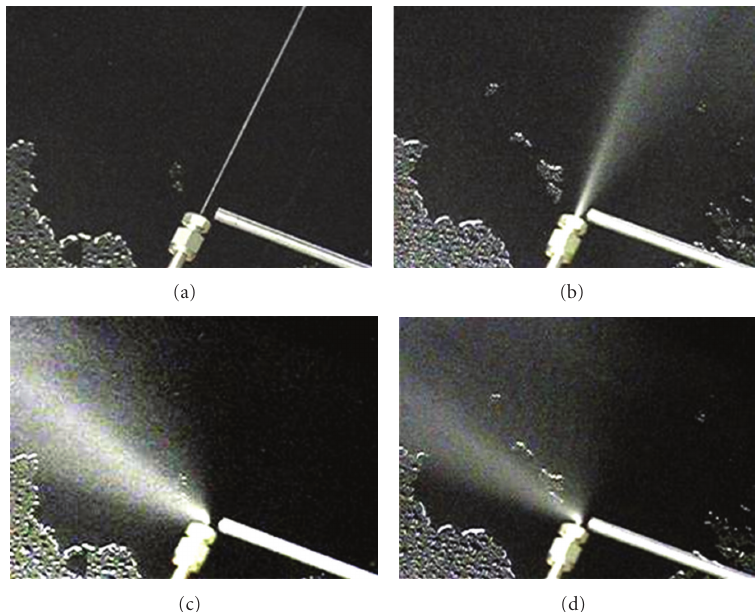
Figure 10: Water atomization. (a) nonaugmented nozzle, (b) flash atomization alone, (c) air-jet blast alone, and (d) flash atomization plus air blast.